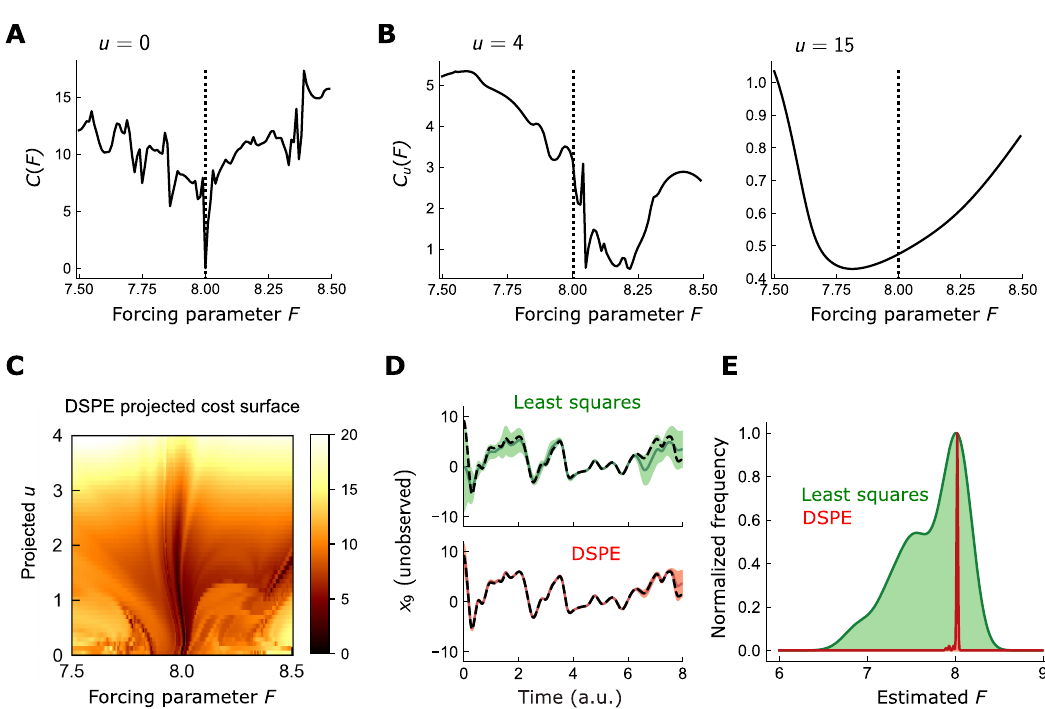
Fig 2. Constraining least-square estimates with controlled dynamics enables robust parameter estimation in chaotic models. A: Squared-difference between 10D Lorenz96 model trajectory x and measured data y , for various values of forcing parameter F , assuming that model was integrated forward from the true initial point. Only states x 1 , x 4 , x 7 , x 10 were measured. The global minimum of C ( F ) (dotted line; F =8), resides in an extremely narrow basin of attraction within a highly nonconvex cost surface. B: Same as A, but for controlled dynamics ( u = 4 and u = 15 for middle and right plots, respectively). Higher controls provide a far smoother cost function around the global minimum. C: 2D projection of the high-dimensional DSPE cost surface, along F in one dimension and the line U ( t ) � u , 8 l , n in the other. Here, x ( t ) were fixed at the values generated by integrating the model forward l n d n from its true initial state for the given F . D: Estimated trajectories of x 8 , using uncontrolled least squares (top; green) and DSPE (bottom; red). Black line: true trajectory. Shaded regions: SD of estimate across 100 random initializations of the optimization. E: Histogram of parameter estimates across 100 initializations of the optimization, for least squares (green) and DSPE (red).